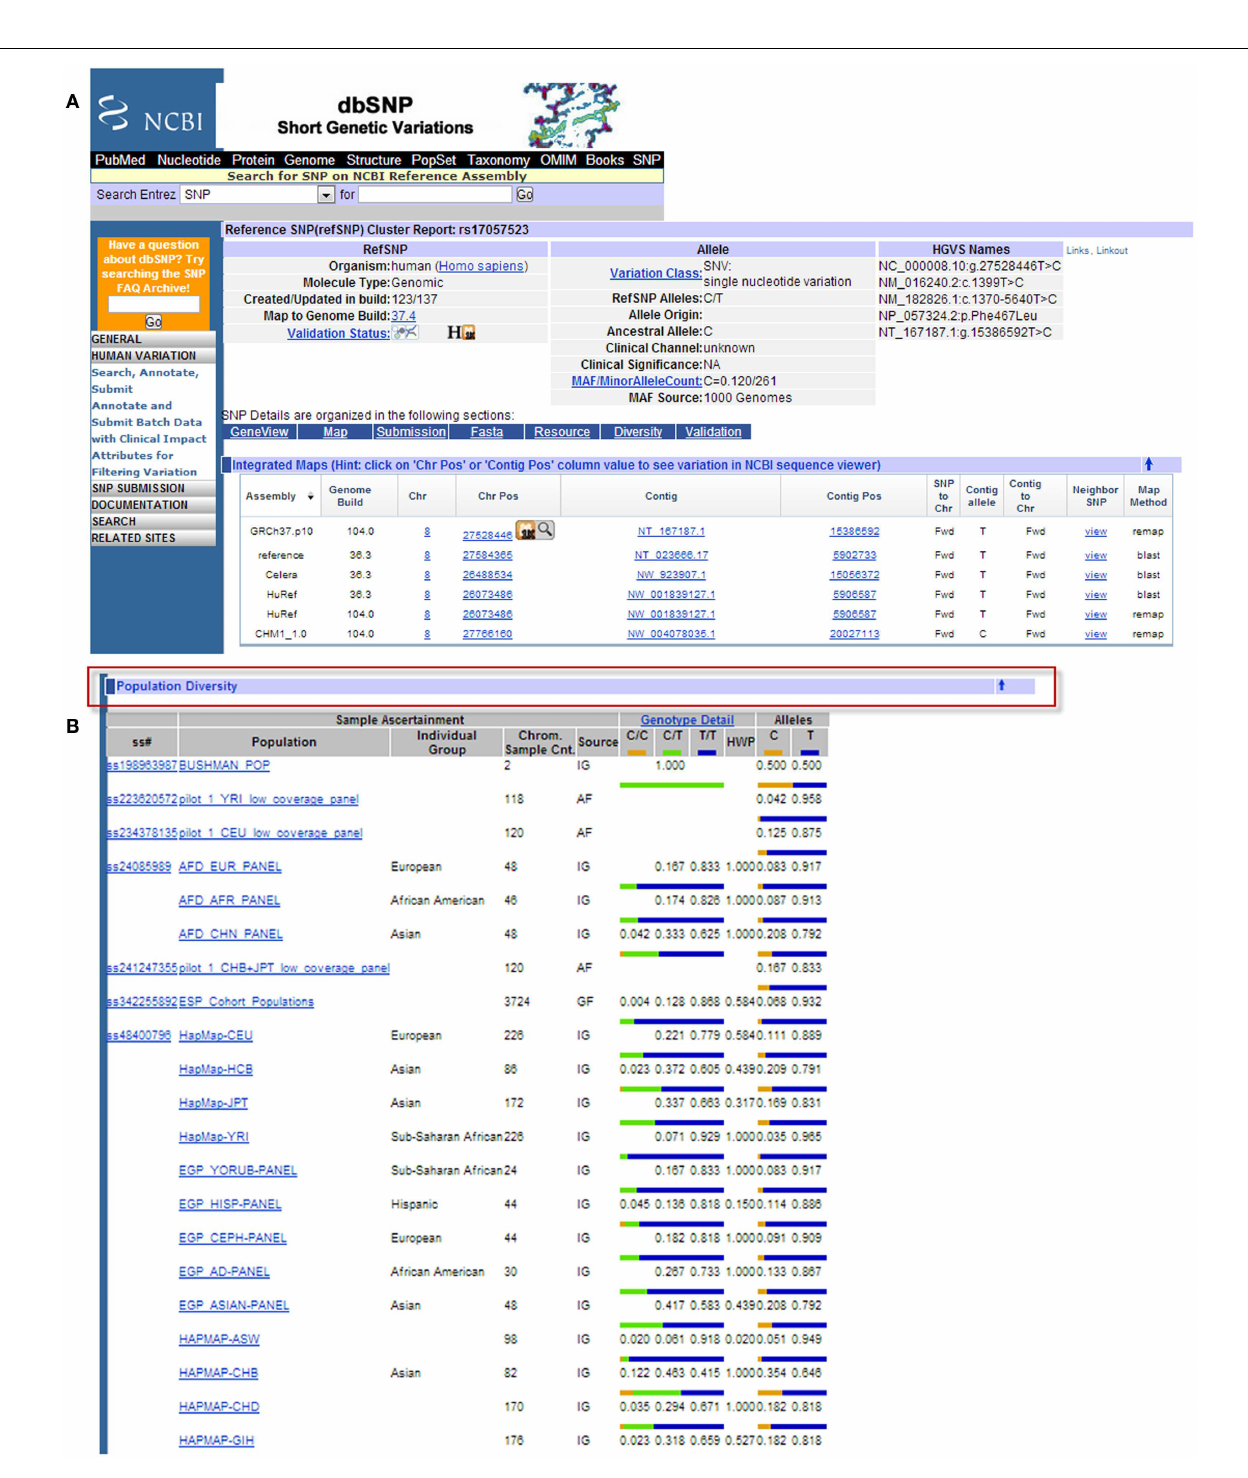
FIGURE 8 | Example results page from the NCBI dbSNP database for SCARA3 SNP rs17057523 . By following the link from the UCSC Genome Browser to dbSNP, more information is provided for SNP rs17057523 including allele frequencies, ancestral alleles, and chromosomal position (A) . Following this information on the database website, are other tabs that